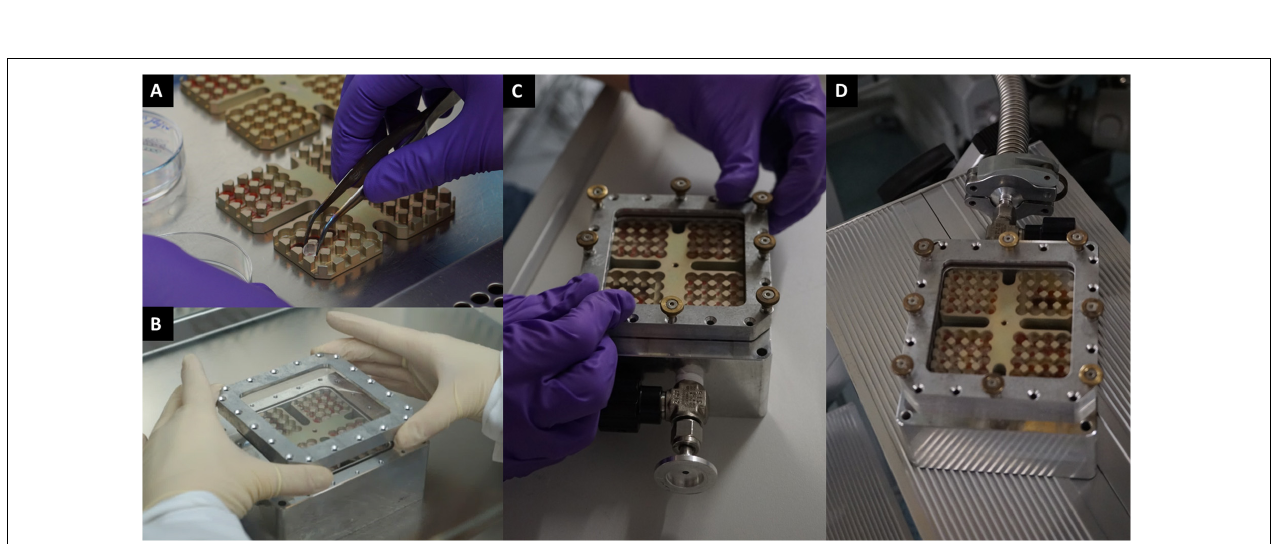
FIGURE 3 | Trex-Box sample preparation. Dimensions of the Trex-Box are 13.5 cm × 13.5 cm × 5.0 cm. The container is a gastight closable stainless-steel box with one borehole which allows an exchange of internal atmosphere. (A) Quartz disks harboring the microbial samples being placed onto the Trex-Box; (B) covering the Trex-Box with a suprasil glass that allows for full UV-VIS exposure; (C) screws were used to tighten and seal the container; (D) Earth’s atmosphere being replaced with Mars-gas mixture.